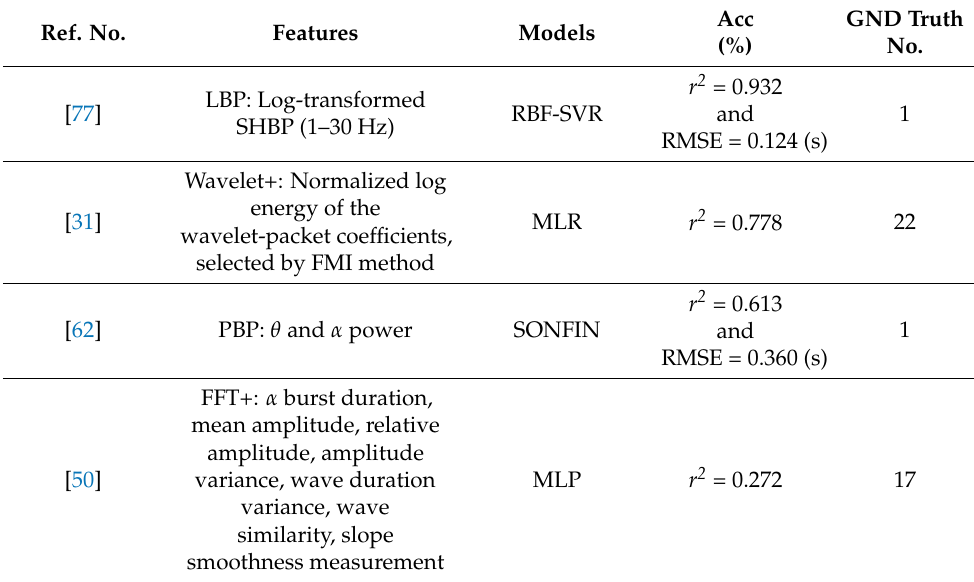
Table 8. EEG-based DDD Accuracies obtained by using Regression Models and Various Features and Ground